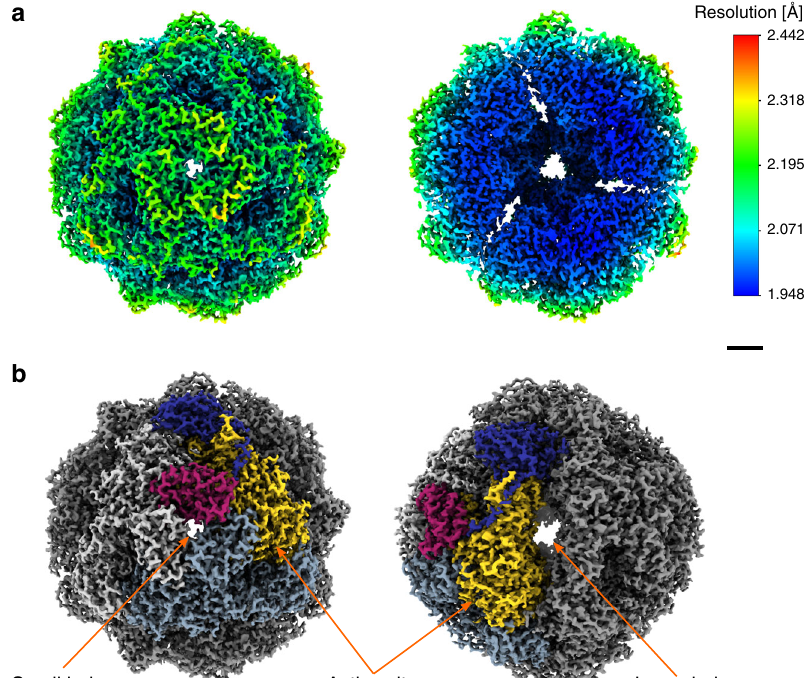
Fig. 2 Cryo-EM analysis of the Y. enterocolitica dodecameric urease assembly. a The cryo-EM map (left) fi ltered and colored by local resolution and a slice cut through the map (right) to show the internal details. b The assembly architecture highlighted on the map. The three chains that form the basic hetero-trimer are shown in different colors, with the other hetero-trimers shown in shades of gray. Two different views are shown to indicate the location of the small and larger holes at the interfaces, as well as the active site. Scale bars: 20